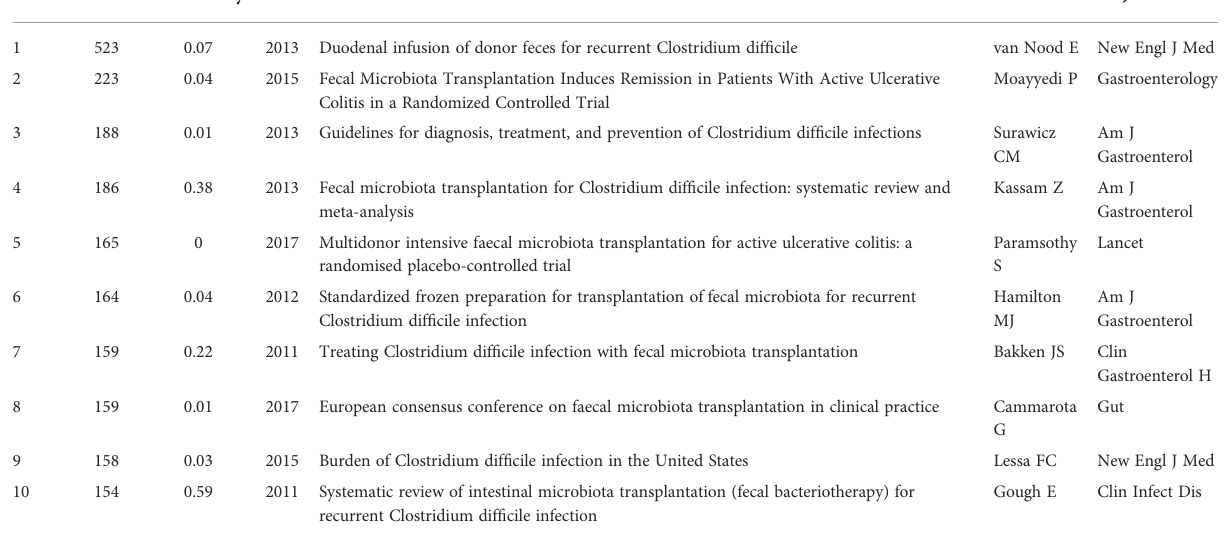
TABLE 7 Top 10 cited references related to FMT research.